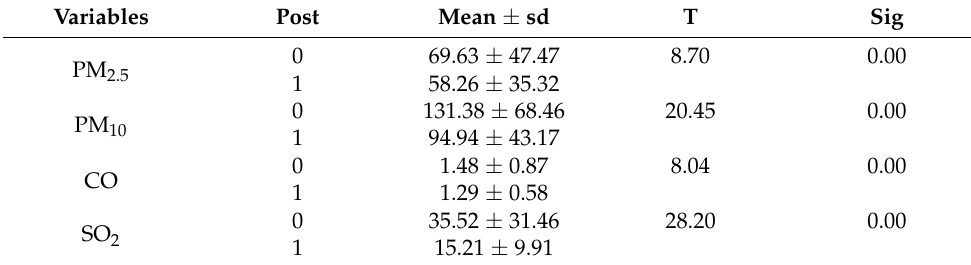
Table 3. T -test results for the whole sample.